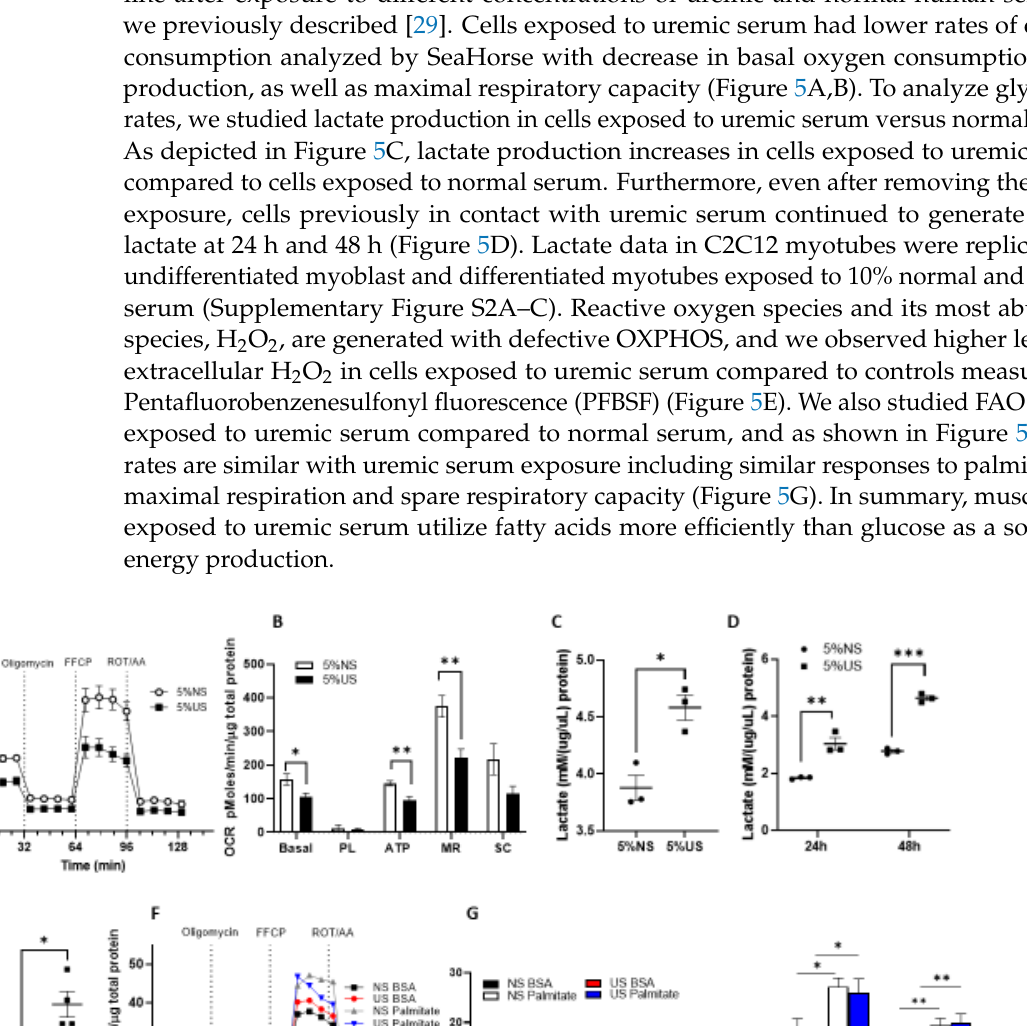
Figure 4. OXPHOS profile of gastrocnemius muscle from CKD mice compared to controls. ( A ) OXPHOS profile and cytochrome C were evaluated by Western blot analysis on gastrocnemius muscle of mice with CKD and controls. The OXPHOS panel includes antibodies against the subu- nits of complexes (I – V) that are labile when the respective complex is improperly assembled. ( B ) Western blot of several mitochondrial enzymes involved in glycolysis. ( C ) OXPHOS panel protein expression normalized by densitometry analysis. ( D ). Mitochondrial protein expression normal- ized by densitometry analysis. (n = 4 – 5). Vinculin, Actin or GAPDH were used as an equal loading control. Unpaired t test with Welch’s correction, error bars represent SEM. * p ≤ 0.05, ** p < 0.01, ***